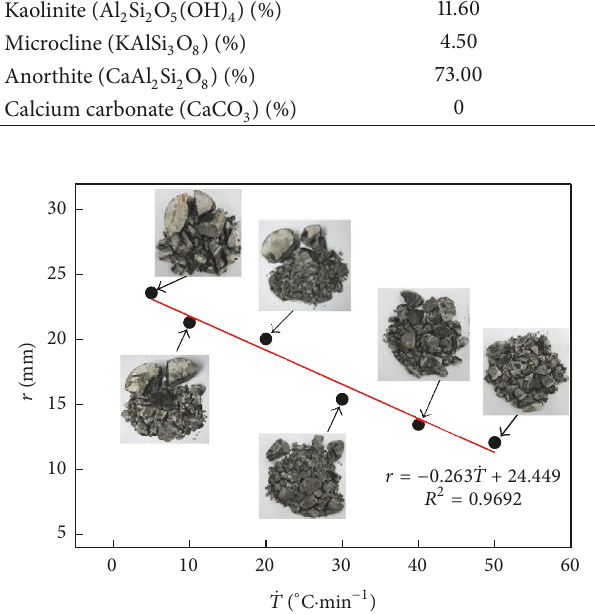
Figure 9: The change rule of fragmentation distribution parameter with heating rates. Figure 9 shows the change rule of the fragmenta- tion distribution parameter, which is dr.